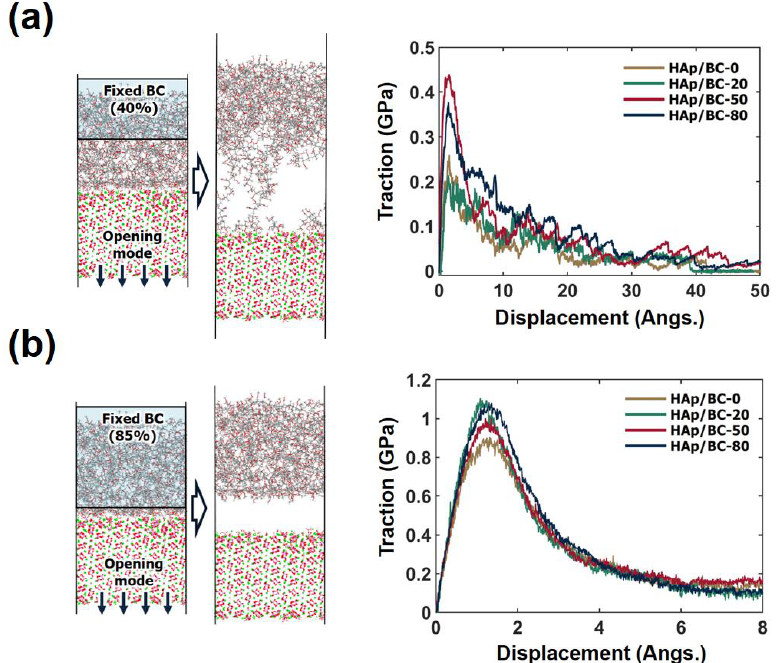
Figure 6. Traction-separation response of the HAp/BC bilayer models, for the opening-mode test. ( a ) 45% and ( b ) 85% of the upper part of the BC was constrained during the descent of the HAp substrate. Table 2. Parameters of the system separation (i.e., 40% of the BC constraint), for the opening-mode test. HAp/BC-0 HAp/BC-20 HAp/BC-50